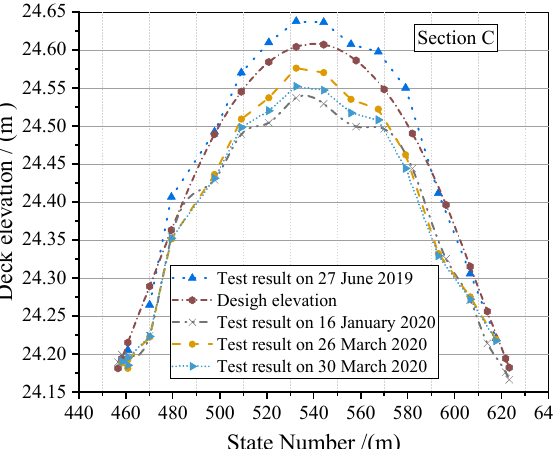
Figure 36. Elevation of the box girder after demolition of rehabilitation measures.